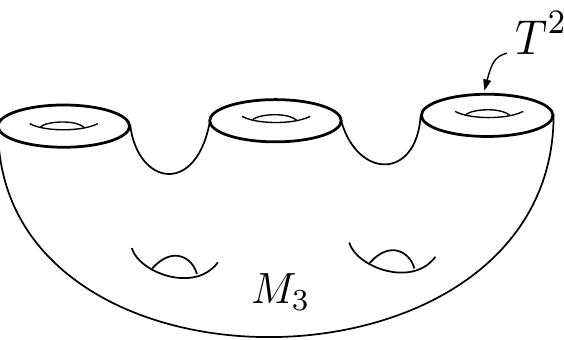
Figure 1 . The spatial manifold (cid:6) n for n = 3 is the disjoint union of three tori. M n is a 3-manifold such that @M n = (cid:6) n